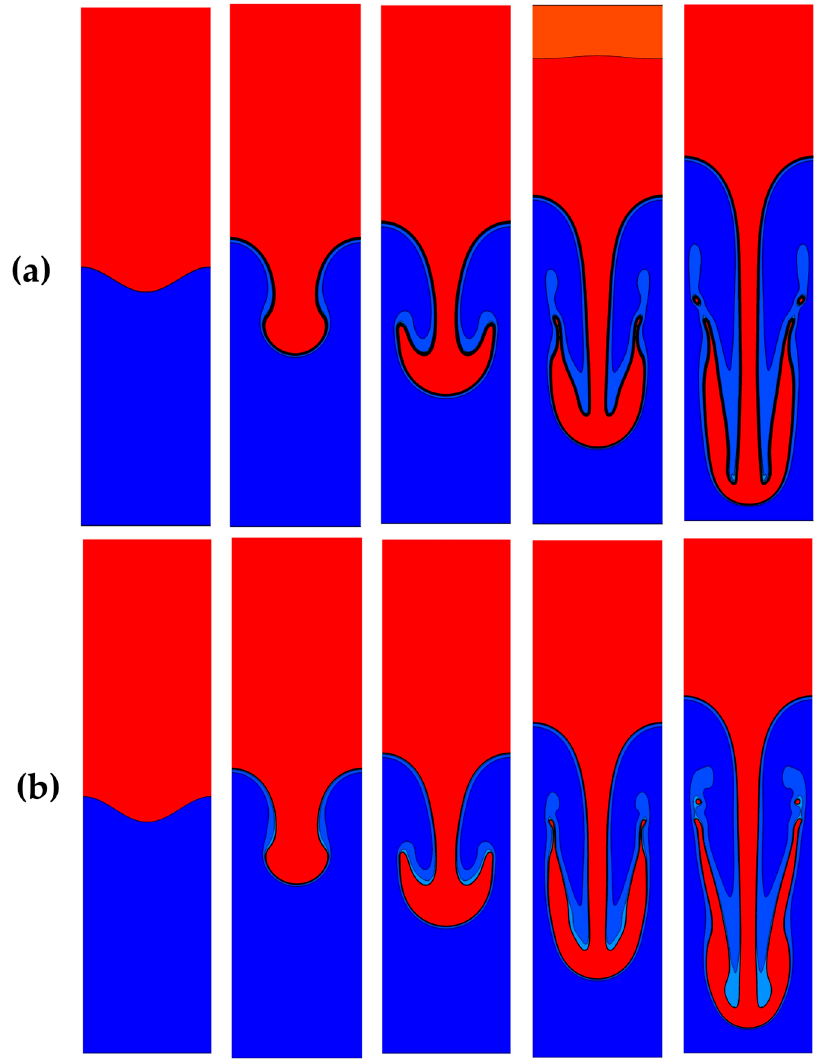
Figure 4. RTI with time plotted on the same density contour levels (Re = 256, At ≈ 0.5, Bo ≈ 100). ( a ) Resolution: 256 × 1024. ( b ) Resolution: 1024 ×